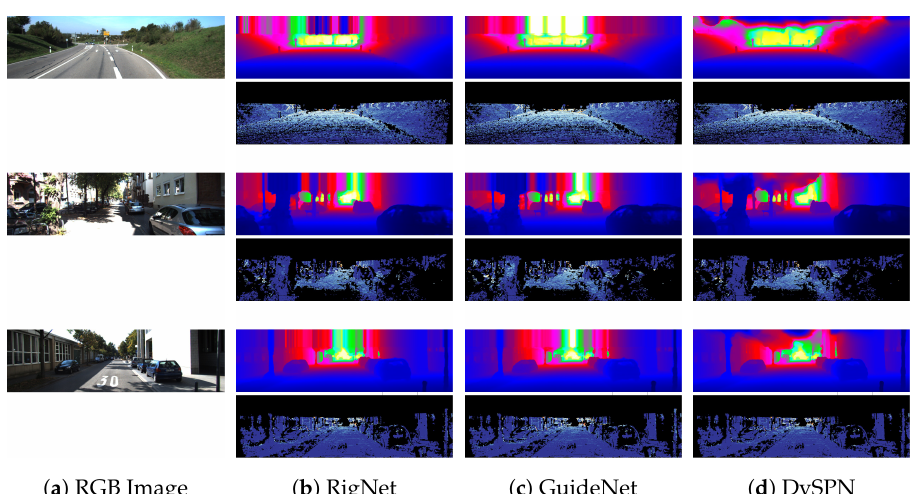
Figure 9. Qualitative comparison of the top three reported methods on KITTI depth completion test set, including ( b ) RigNet [33], ( c ) GuideNet [51], and ( d ) DySPN [60]. Given sparse depth maps and the input guidance color images ( a ), the methods output dense depth predictions (1st row). The corresponding error maps (2nd row) are taken from the KITTI leaderboard for comparison. Warmer color represents higher